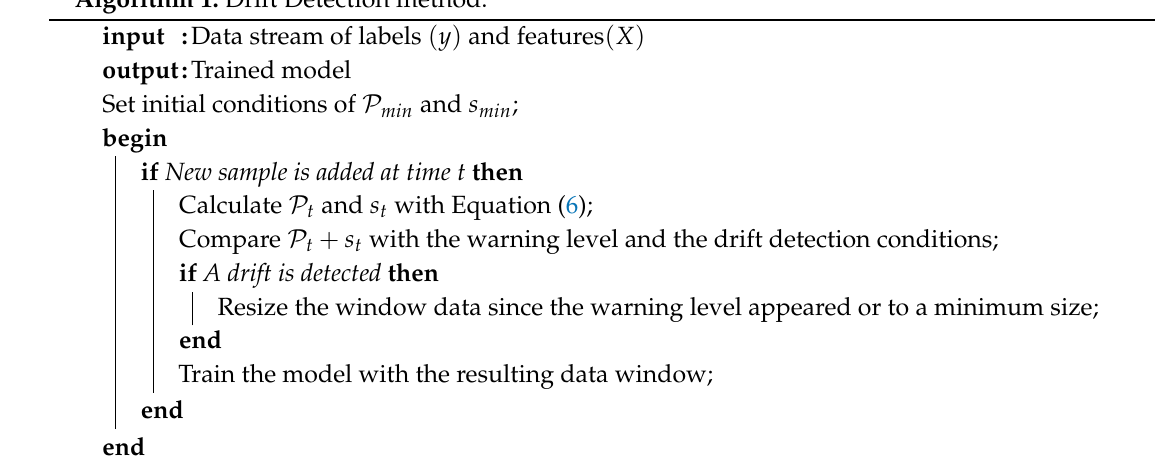
Algorithm 1: Drift Detection